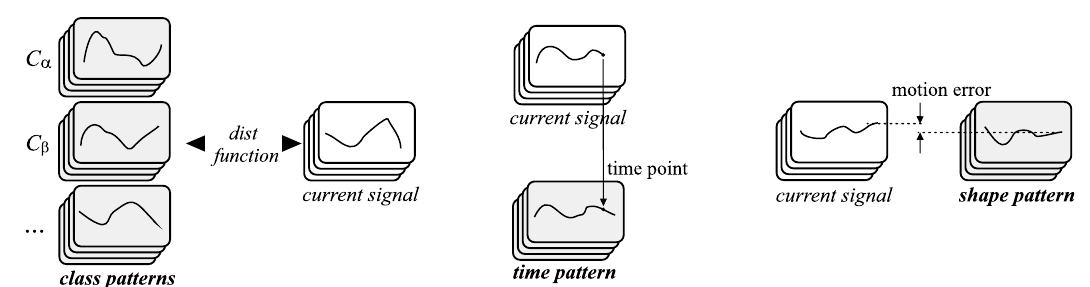
Figure 5. The multi-dimensional signals and patterns applied in the motion learning system: the current multi-dimensional signal and the collection of multi-dimensional class patterns for the classification process (left side), current multi-dimensional signal and multi-dimensional time pattern, and current multi-dimensional signal and multi-dimensional shape pattern.